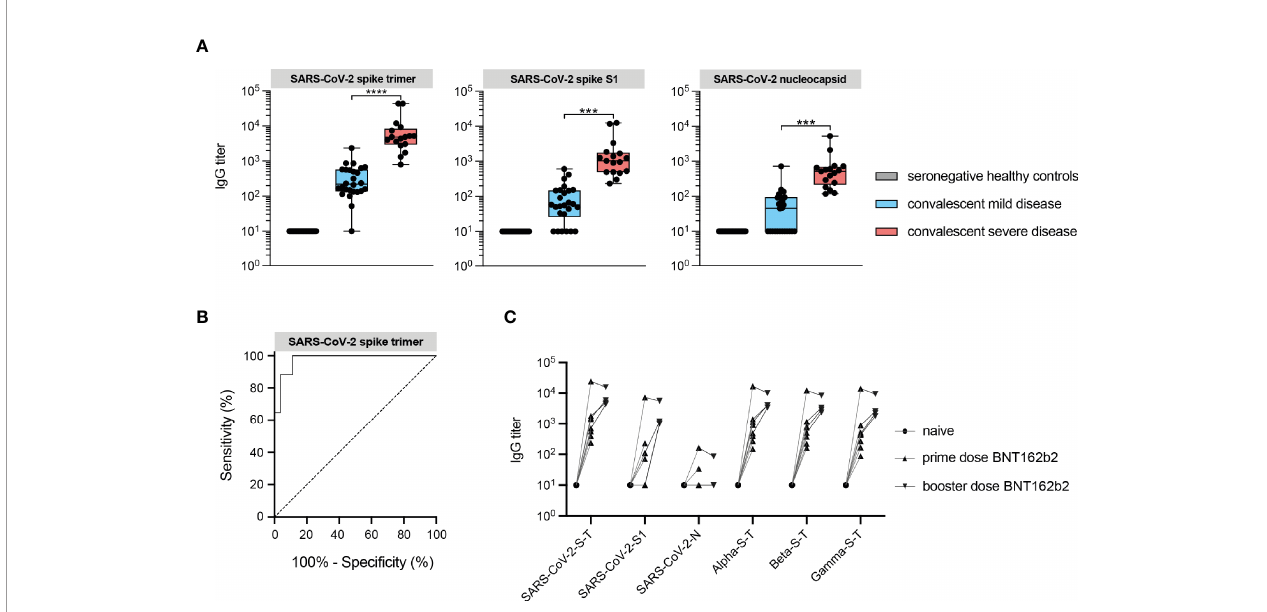
FIGURE 1 | IgG responses against structural viral epitopes in convalescent sera distinguishes hospitalized patients with severe disease from mild/asymptomatic disease. (A) IgG antibody responses against SARS-CoV-2 recombinant spike and nucleocapsid structural proteins measured by protein microarray in convalescent sera from COVID-19 patients (red box), mild/asymptomatic disease controls (blue box) and unexposed healthy controls (gray box) Data are represented as the median titers (min and max value). (B) Receiver operating characteristic (ROC) curve analysis of protein microarray for discrimination between convalescent patients with severe COVID-19 requiring ICU care and those with mild/asymptomatic disease. (C) Vaccine-induced IgG antibody responses in seronegative healthy individuals vaccinated with spike mRNA vaccine (BNT162b2). SARS-CoV-2 refers to the original Wuhan-1 strain. ***P ≤ 0.001, ****P ≤